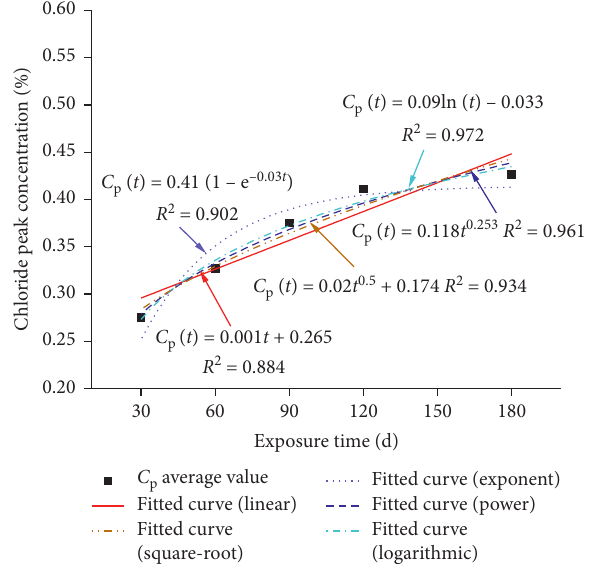
Figure 9: Fitted curves of time-dependent chloride peak concentration.